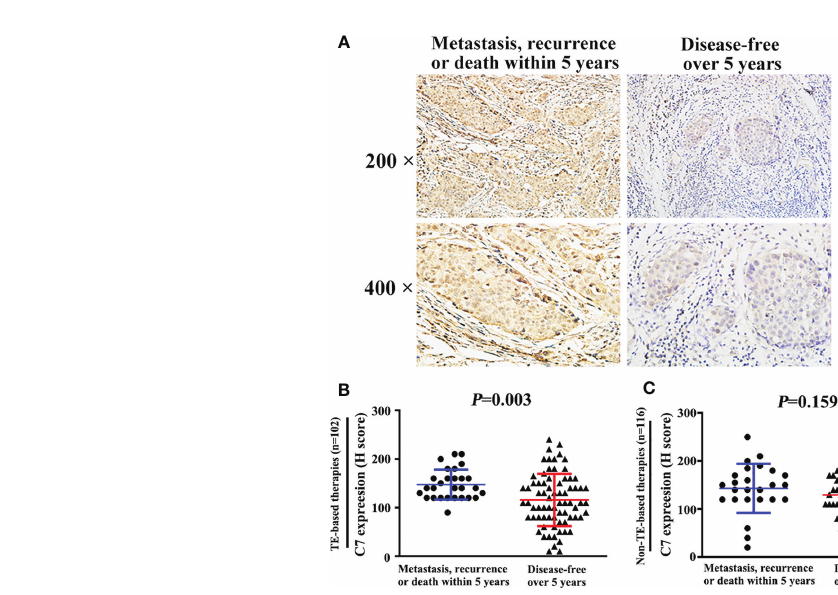
FIGURE 7 | High expression of C7 promoted breast cancer progression in patients treated with TE-based chemotherapy. (A) Among 102 patients treated with TE- based chemotherapy, representative images of C7 expression in patients who developed metastasis, recurrence, or death within 5 years and patients who were disease-free over 5 years, respectively (magni fi cation 200× and 400×). (B) Among TE-based chemotherapy-treated patients, C7 expression in patients who developed metastasis, recurrence, or death within 5 years was higher than those who were disease-free over 5 years. (C) Among non-TE-based chemotherapy- treated cases, no signi fi cant difference of C7 expression was found in patients who developed metastasis, recurrence, or death within 5 years and those who were disease-free over 5 years. [ (B, C) : Mann-Whitney U test].